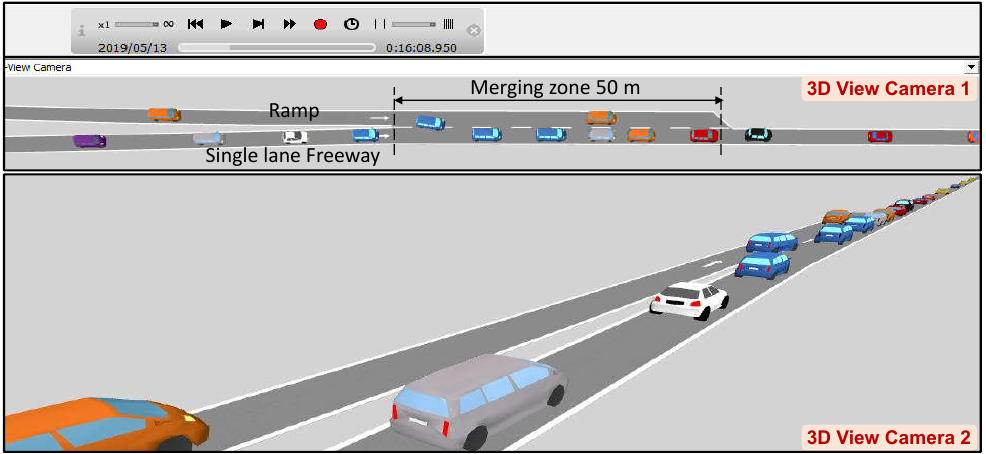
Figure 5. The simulation scenario in the AIMSUN traffic simulator viewed from two different cameras. Vehicles can merge into the freeway at any point in the merging zone of 50